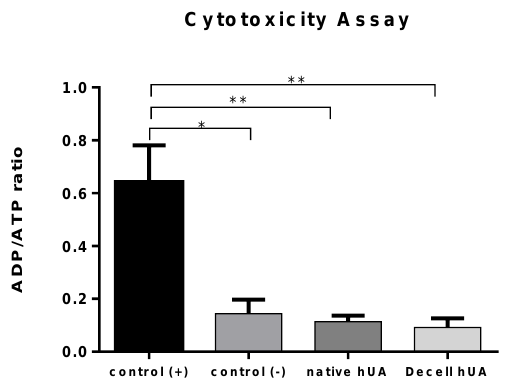
Figure 3. ADP/ATP ratio assay. Low ADP/ATP ratio values indicates that the cells preserved their proliferation capacity. * p < 0.05, ** p < 0.001.